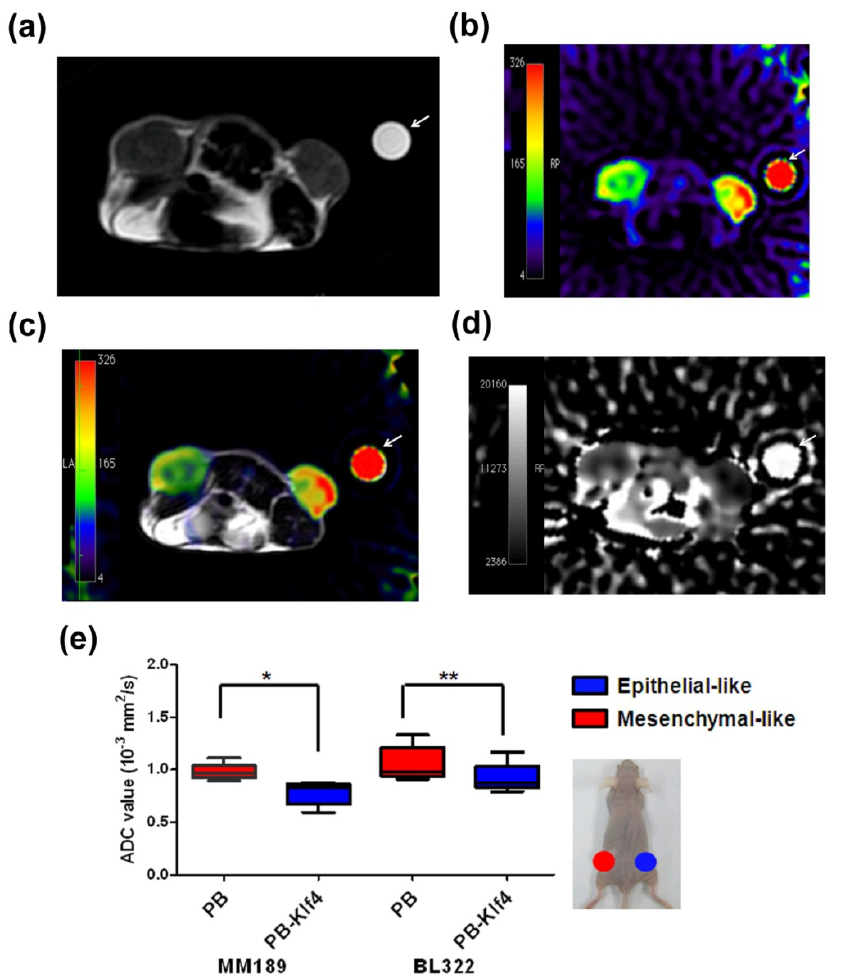
Figure 2. Application of periodically rotated overlapping parallel lines with enhanced reconstruction diffusion-weighted magnetic resonance imaging (DW-MRI) for in vivo visualization of epithelial- and mesenchymal-like tumors. ( a ) A tumor-bearing mouse carrying a left flank MM189 PB (mesenchymal-like) tumor and a right flank MM189 PB-Klf4 (epithelial-like) tumor. T2-weighted MRI shows no apparent difference in signal intensity between the bilateral flank tumors. A water phantom (white arrow) was placed within the field of view as a measuring reference; ( b ) Color-coded DW-MRI ( b = 750 s/mm 2 ) was used to visualize the signal intensity of bilateral flank tumors. Relative hyperintensity of right flank tumors ( red ) compared with left flank tumors ( green ) was observed; ( c) Color-coded map of DW-MRI was layered over the gray-scaled anatomic T2-weighted images; ( d ) Apparent diffusion coefficient (ADC) map shows that the right flank MM189 PB-KLF4 tumor was hypointense relative to left flank MM189 PB tumor; and ( e ) Both epithelial-like MM189 PB-Klf4 and BL322 PB-Klf4 tumors showed significantly lower ADC values compared with that of the corresponding mesenchymal-like controls MM189 PB and BL322 PB, respectively. * p < 0.05; ** p <